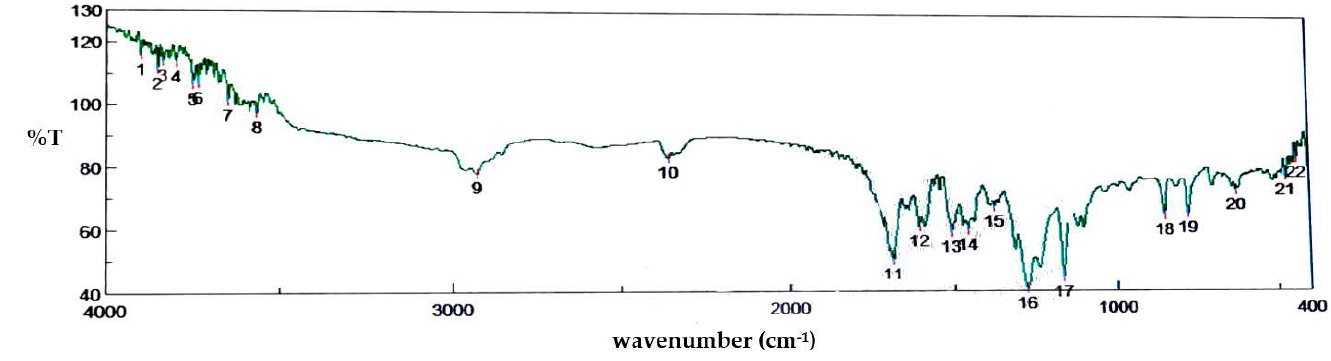
Figure 2. FTIR spectra of the formulation ingredients such as silymarin, carbopol and other excipients .